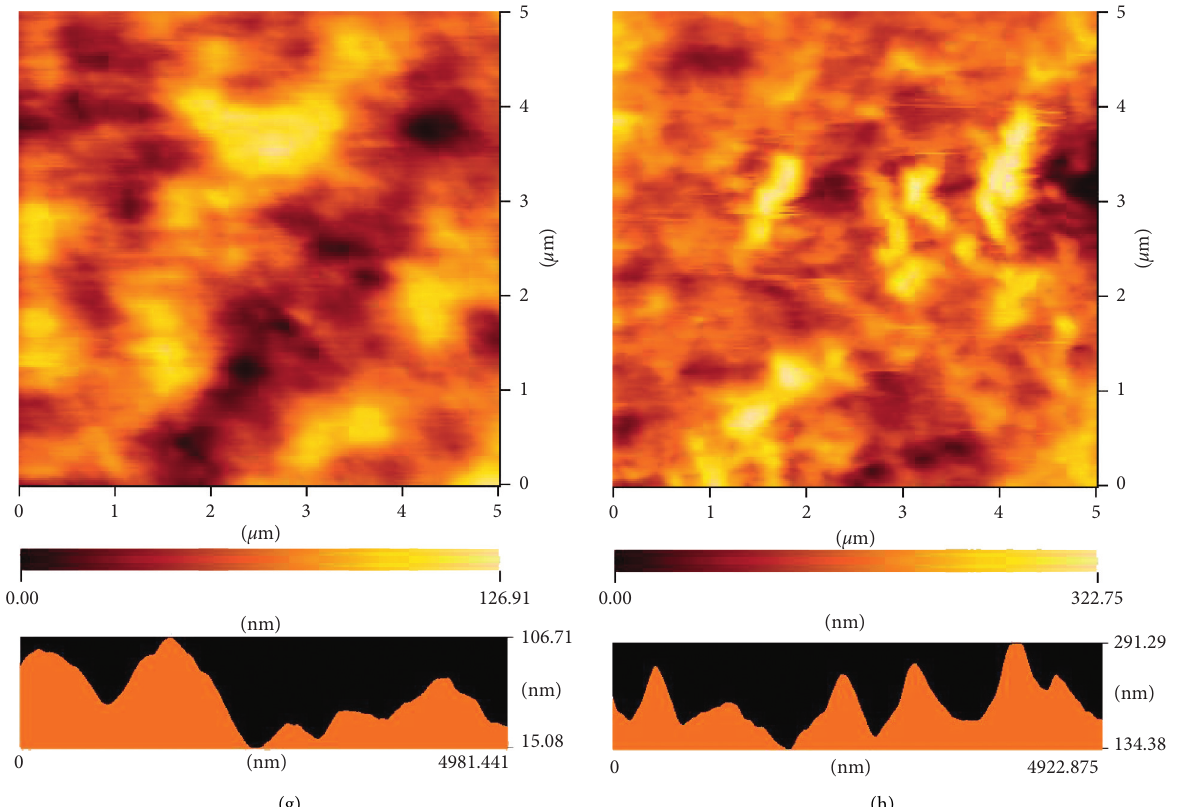
Figure 10: AFM images of the chitin hydrogel (a–d) C1-3–C1-10 and (e–h) C2-3—C2-10 at 5 µ m 2 scanning area.